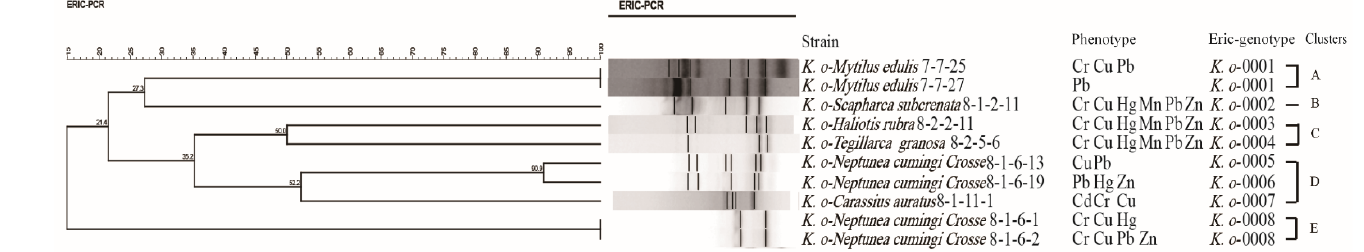
Figure 6. ERIC-PCR-based genotyping of the 10 K. oxytoca isolates with MDR phenotypes.